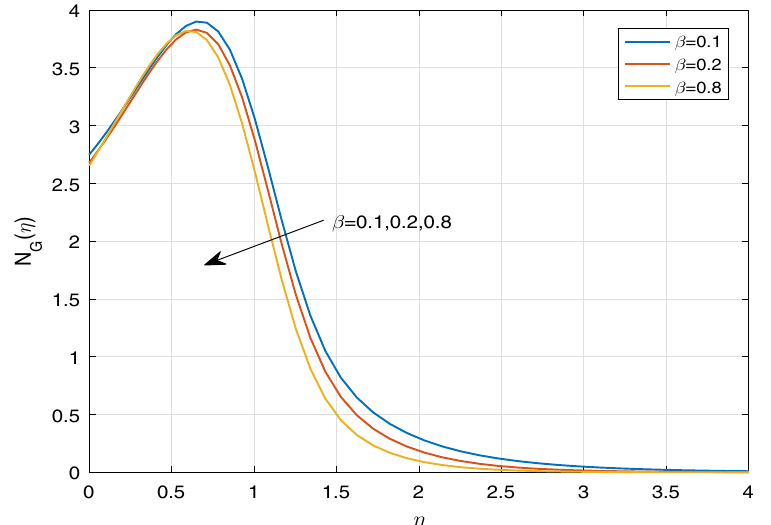
Figure 15. Sketch of N G against β .